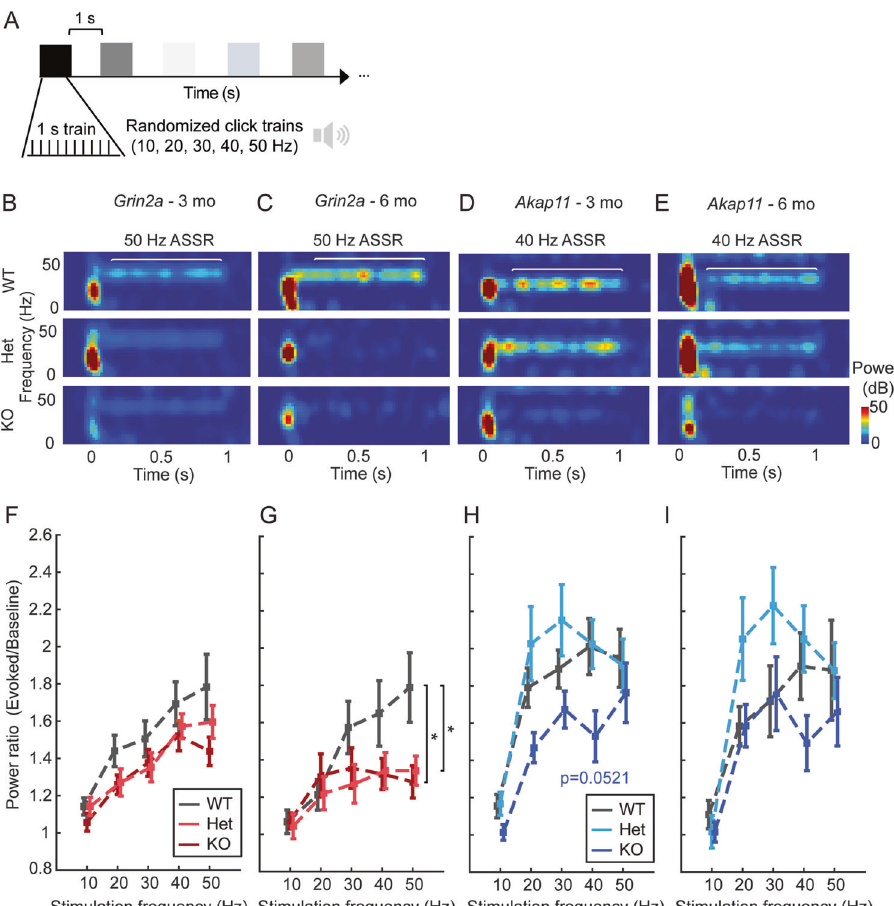
Fig. 5 Auditory steady-state responses (ASSR) in Grin2a and Akap11 mutants. A Schematic of ASSR paradigm. B – E Representative ASSR for 3- and 6-month-old Grin2a and Akap11 animals. F – I Power ratio quanti fi cation of the evoked (0.2 – 1 s post-stimulus) / baseline (0.5 s pre- stimulus) response for 10-50 Hz auditory stimulation (evaluated using Welch ’ s method, window = 0.5 s, overlap = 0.25 s). Asterisks indicate signi fi cant differences in Het or KO vs. WT littermates ( p < 0.05). Error bars denote mean ± standard